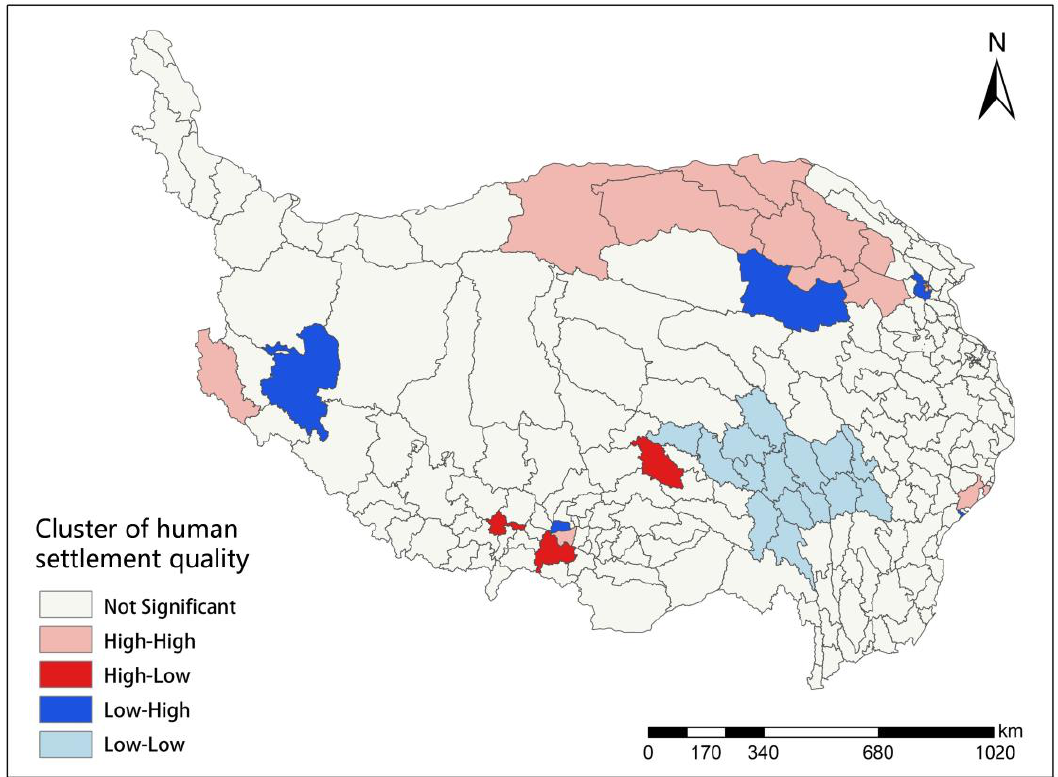
Table 2. Global Moran’s I index of human settlement quality in the Qinghai– Tibet Plateau.